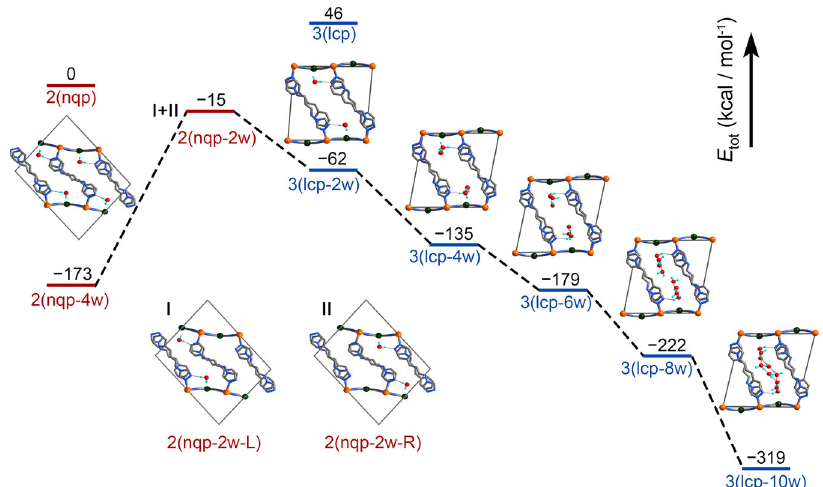
Fig. 6 Energy diagram of water adsorption. The adsorption-induced nqp – to – lcp lattice transformation experiences simultaneous pore opening and closing (nqp-4w to nqp-2w state) with a large energy requirement of 158 kcal mol − 1 , after which nqp-2w-L/R can be converted to lcp-2w to reduce the lattice energy.